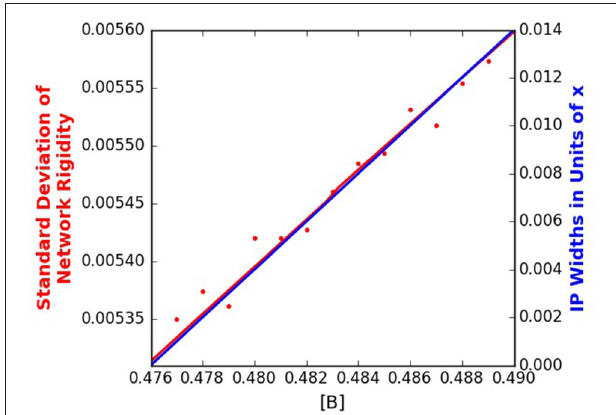
FIGURE 8 | The standard deviation of the distribution of constraints, n , and the resulting intermediate phase width, w x , for f thres =